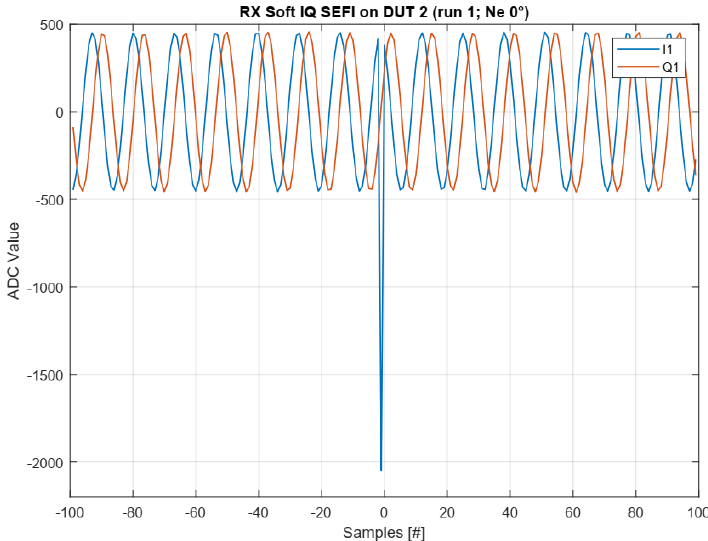
Figure 14. Soft IQ SEFI on channel 1 (I1 / Q1) of the DUT 2 receiver, showing an SEU in the ADC data.